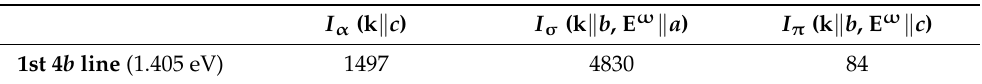
(cid:82) k ( ν ) d ν , j = α , σ , π (in cm − 2 ) of